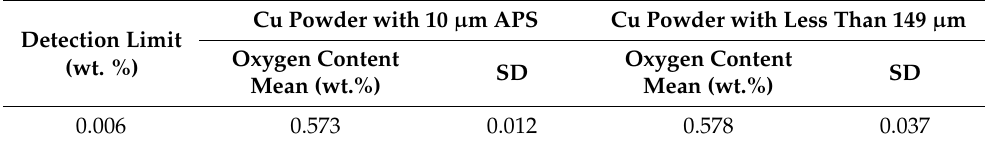
Figure 3. XRD micrograph of the spherical Cu powders. Table 2. Oxygen content measurement (wt%) of the two Cu metal